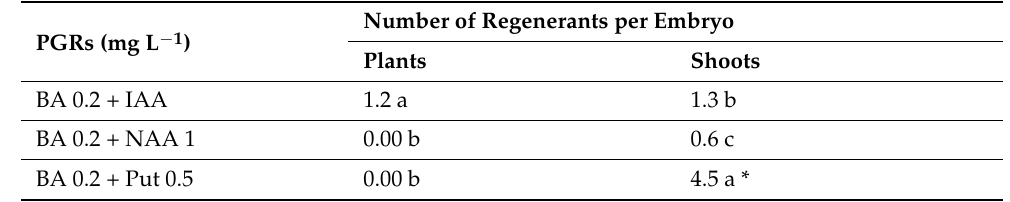
Table 4. Effect of PGRs on plant regeneration from gynogenetic embryos of red beet “Czerwona Kula”. Basal MS medium containing 30 g L − 1 sucrose was used for plant regeneration.